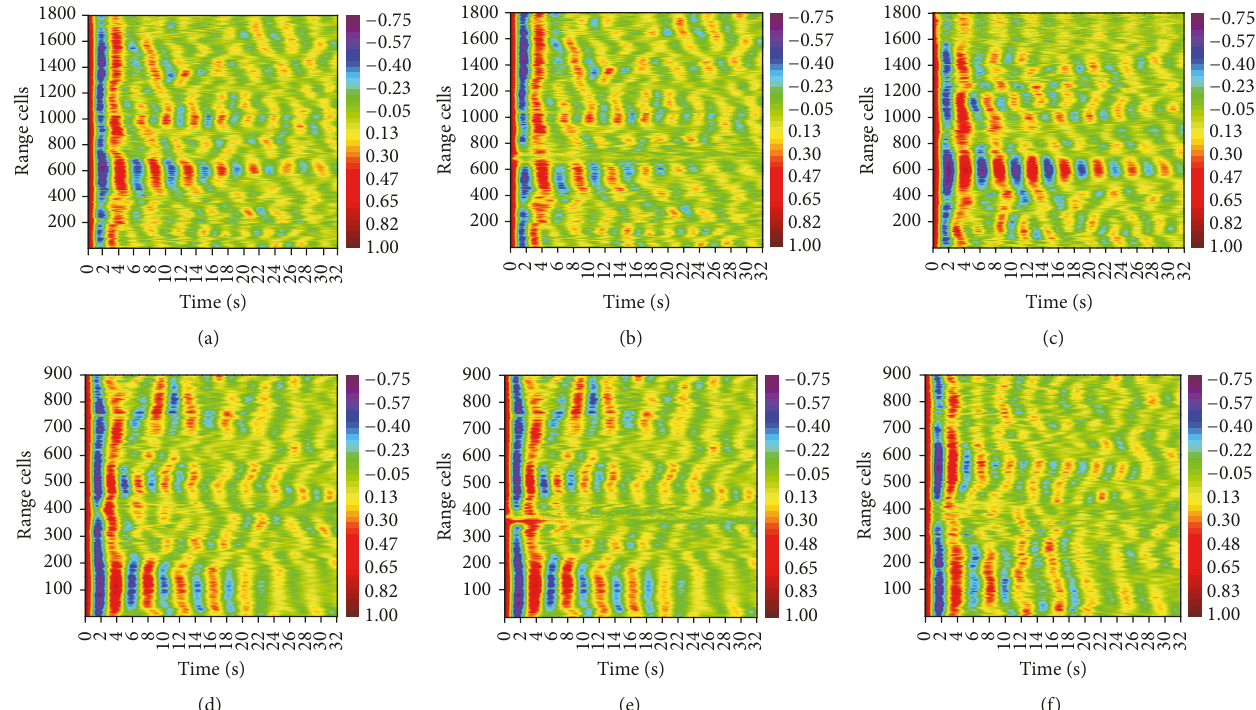
Figure 9: The temporal correlations of the texture: ((a)–(c)) sum channel and elevation and azimuth difference channels for DS1. ((d)–(f)) Sum channel and elevation and azimuth difference channels for DS2.